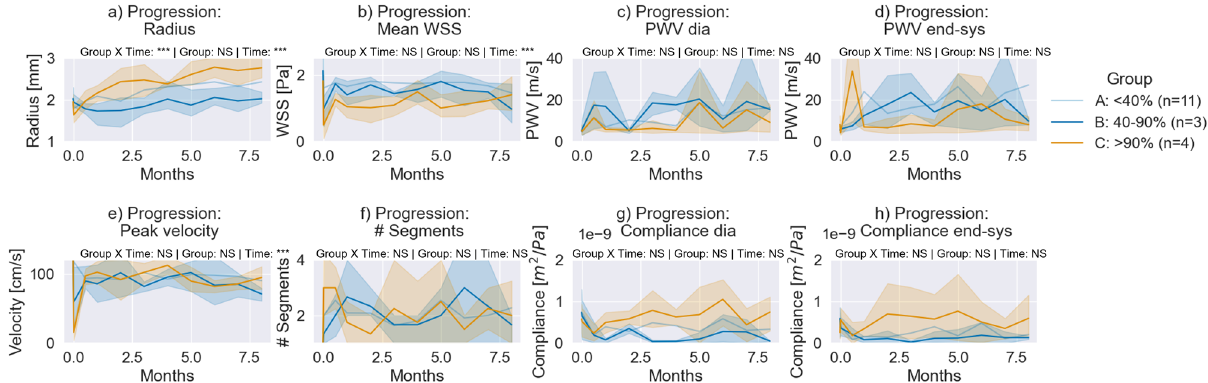
Figure 3. Progression of derived markers for the ligated carotids of groups B (blue) and C (orange). The stiffness of the less ligated group (40–90%) increases as indicated by the compliance ( g , h ) and the PWV ( c , d ), whereas the stiffness of the ligated group decreases. Furthermore, a distinct progression in the radius can be observed ( a ). ( a ) The radius of the carotid lumen. ( b ) The estimated temporal-averaged wall shear stress. ( c ) The pulse wave velocity at diastolic (dia) pressure. ( d ) The pulse wave velocity at end-systole (end-sys). ( e ) The peak velocity. ( f ) The number of detected segments. ( g ) The compliance at diastolic (dia) pressure. ( h ) The compliance at end-systole (end-sys). The data are represented as the mean (bold) and the 95% confidence interval (transparent). Two-way mixed ANOVA was conducted to quantify the significance (*<0.05, **<0.01 and ***< 0.001, with Holm-Sidak correction).